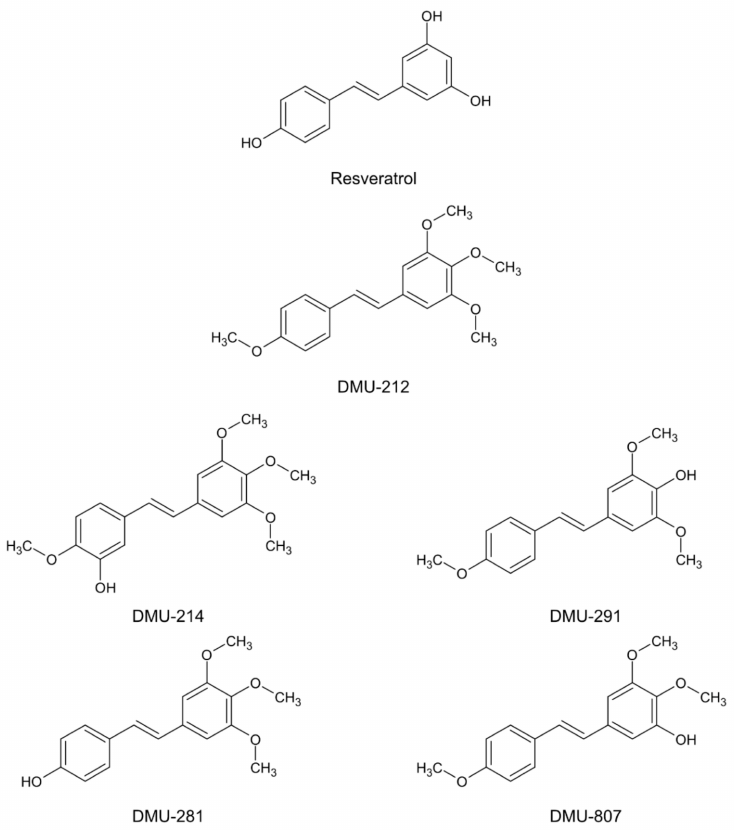
Figure 1. The chemical structures of resveratrol (the prototype compound), methylated resveratrol analogue (DMU-212) and its metabolites (DMU-214, DMU-291, DMU-281,